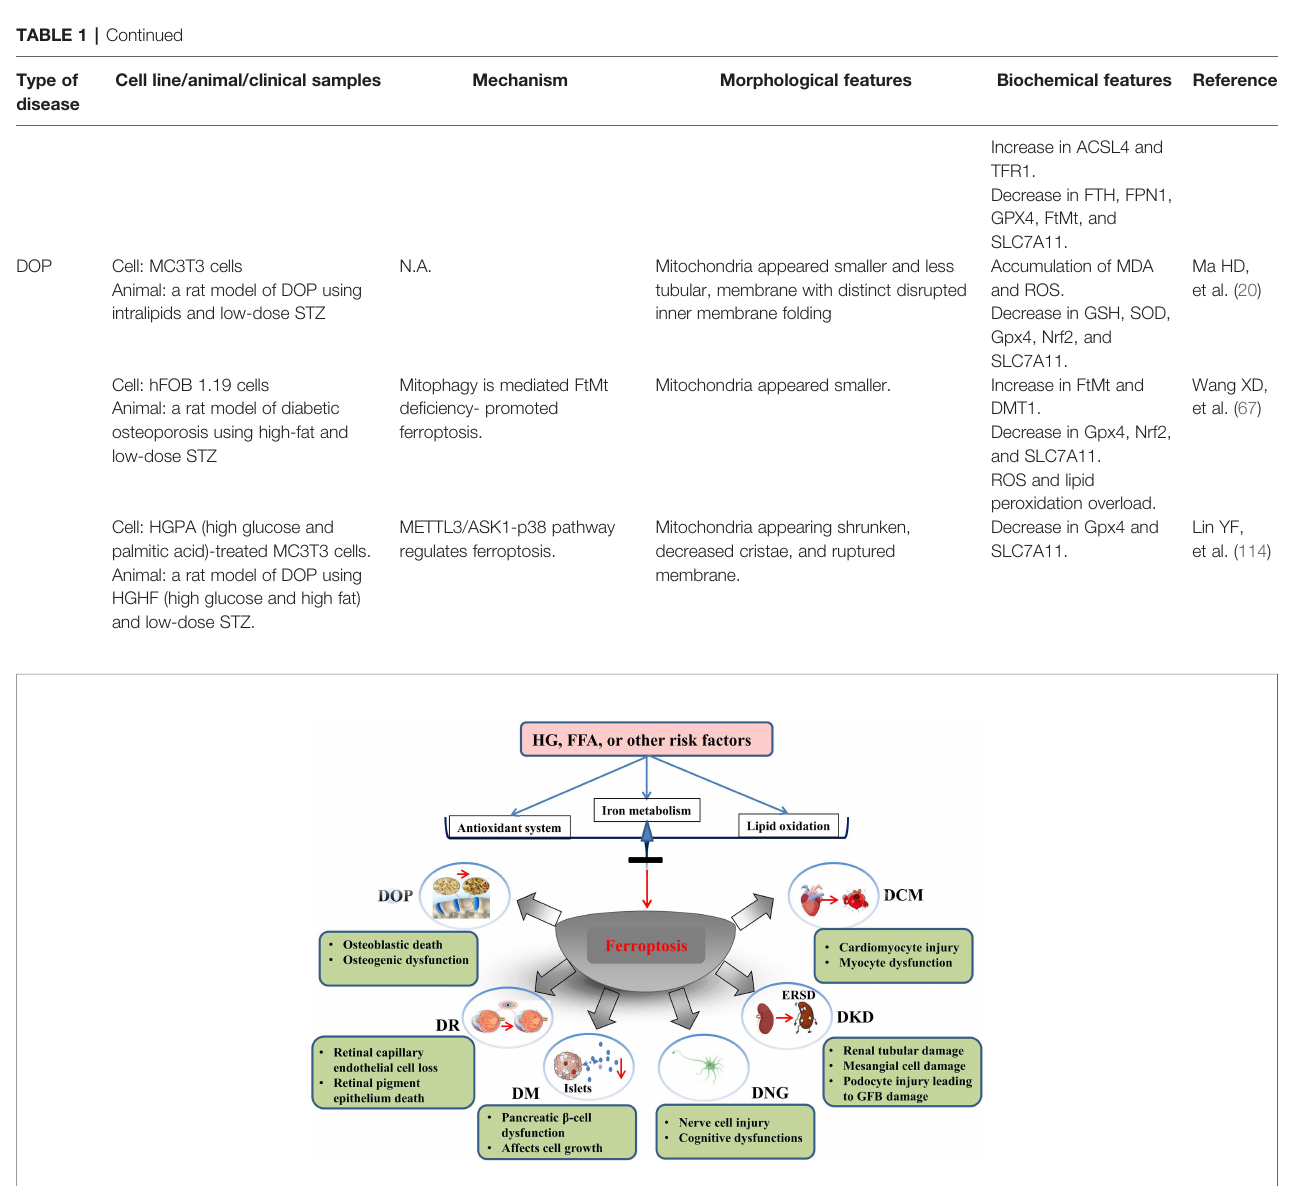
FIGURE 3 | Ferroptosis is involved in the development of diabetes and related complications. HG and other risk factors (FFA or H/R) could induce ferroptosis by interfering with the balance of ion metabolism, reduction system, and lipid oxidation. Ferroptosis is involved in cell death of target organ and dysfunction in diabetes and its metabolic